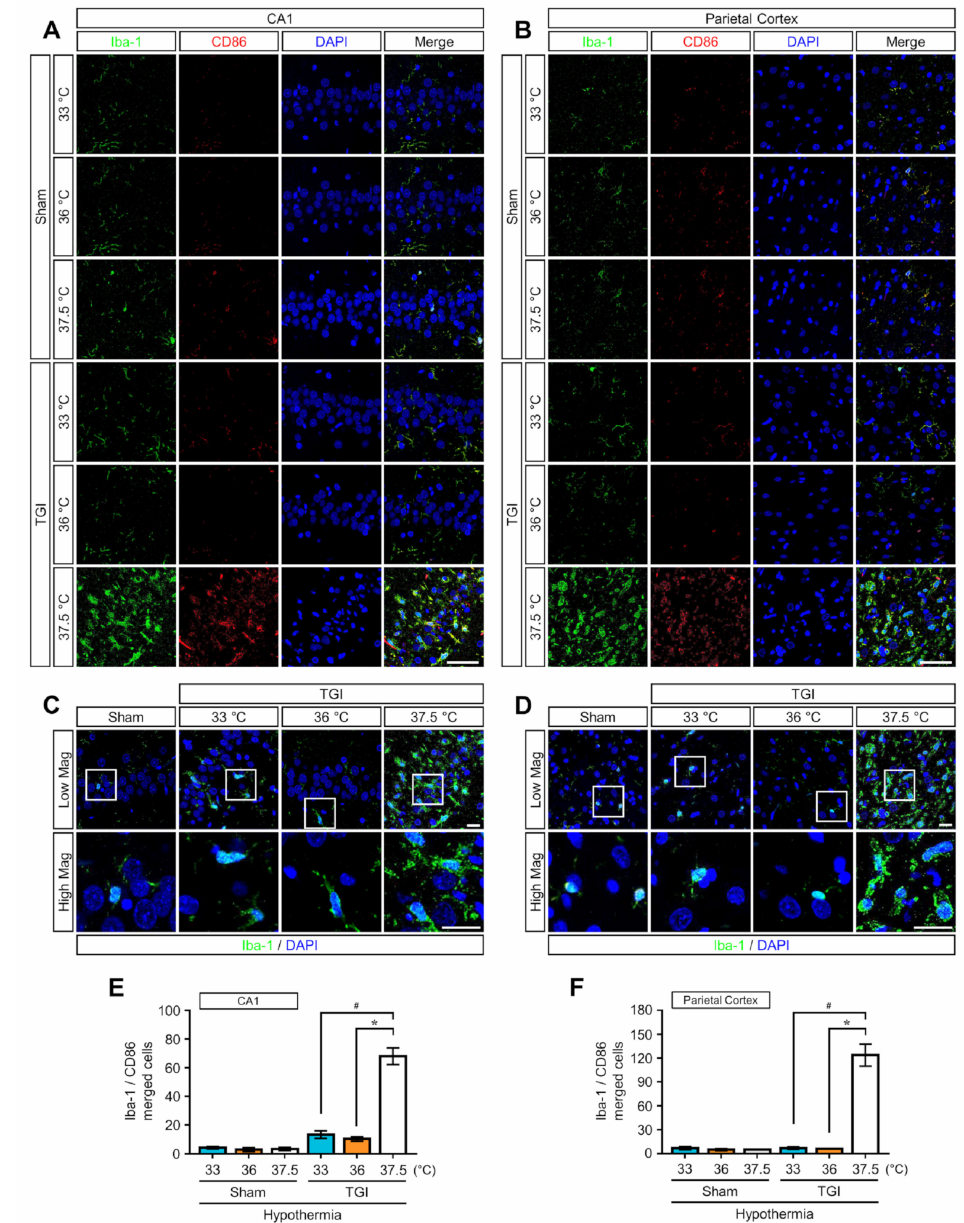
Figure 4. TGI-induced high mobility group box 1 release in the early stage triggers microglial activation and M1 type polarization. TTM at 33 ◦ C and 36 ◦ C inhibits this. ( A , B ) At 72 h after TGI, representative images show microglial activation and M1 type polarization in both the sham and TGI groups in the hippocampal cornus ammonis 1 and parietal cortex. The sham groups had no differences in microglial activation and polarization. TGI to normal temperature at 37.5 ◦ C triggered microglial activation (Iba-1, green signal) and M1 type polarization (CD86, red signal). Scale bar = 50 µ m. ( C , D ) Image shows low and high magnification of Iba-1-positive microglial cells in hippocampal cornus ammonis 1 region and parietal cortex. Scale bar = 20 µ m. ( E , F ) Bar graph shows the percentage of Iba-1 and CD86 emerging in the hippocampal cornus ammonis 1 and parietal cortex. TGI-TTM at 33 ◦ C and 36 ◦ C had a lower percentage than TGI at 37.5 ◦ C (one way-ANOVA, multiple comparison following Bonferroni adjustment. Sham + 33 ◦ C, n = 3; Sham + 36 ◦ C, n = 4; Sham + 37.5 ◦ C, n = 6; TGI + 33 ◦ C, n = 5; TGI + 36 ◦ C, n = 8; TGI + 37.5, n = 6. * p and # p <